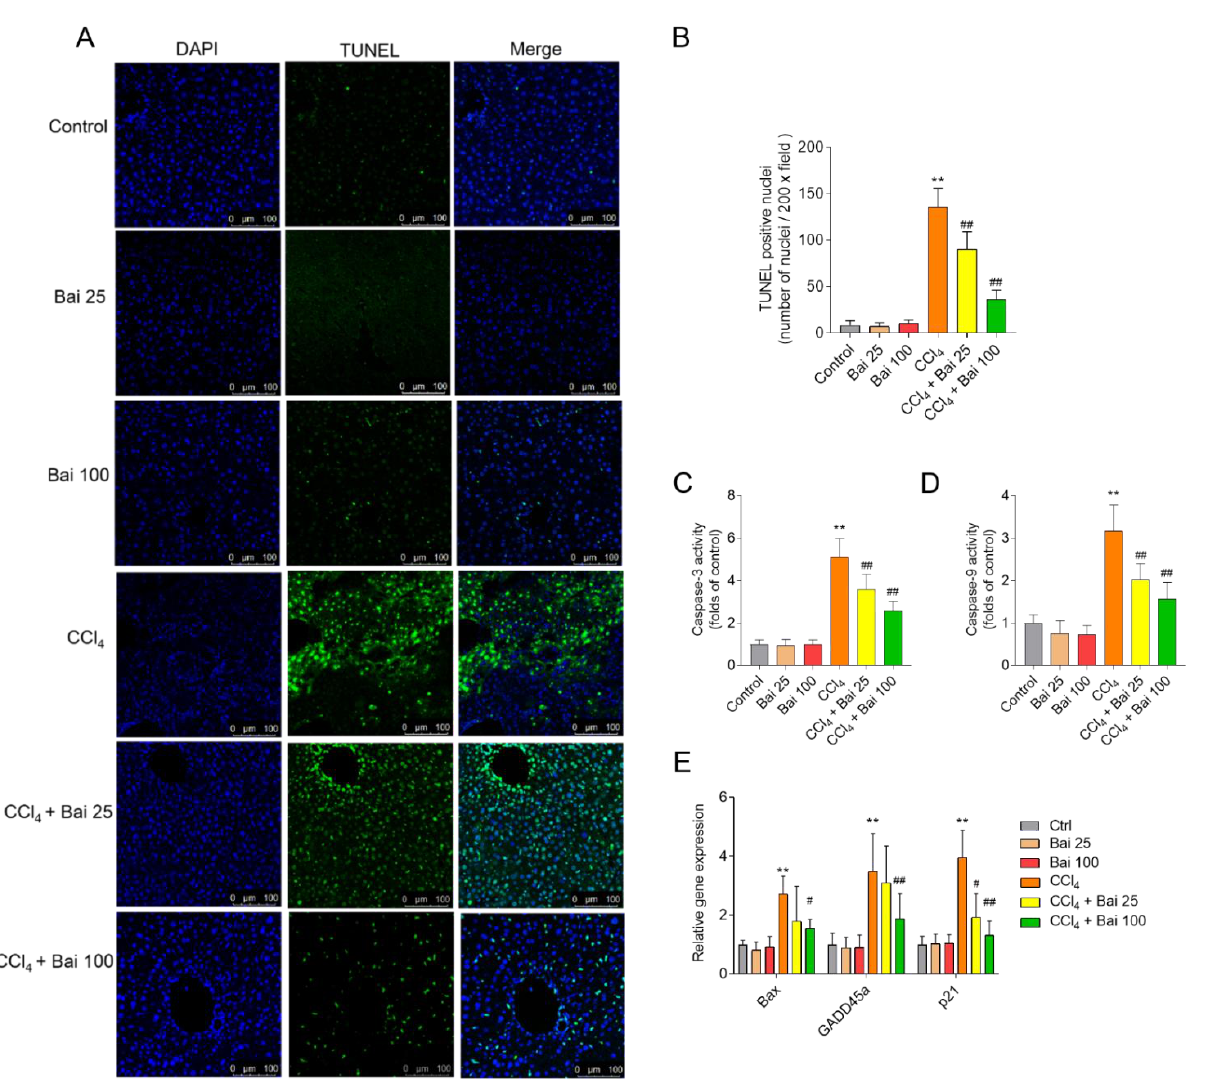
Figure 6. Effects of baicalein supplementation on apoptotic pathway in the liver tissues of mice challenged with CCl 4 . ( A ) Representative TUNEL-stained sections showing apoptosis in the liver tissue of mice. ( B ) Quantitative analysis of TUNEL positive rates ( n = 4). ( C , D ) Activities of ( C ) caspases-3 and -9 ( D ) ( n = 6). ( E ) The relative expression of Bax , GADD45a and p21 mRNAs in the liver tissues ( n = 5). ** p < 0.01, compared to the control group; # p < 0.05 or ## p < 0.01, compared to the CCl 4 only group. Bar = 100 μm. Bai: baicalein.